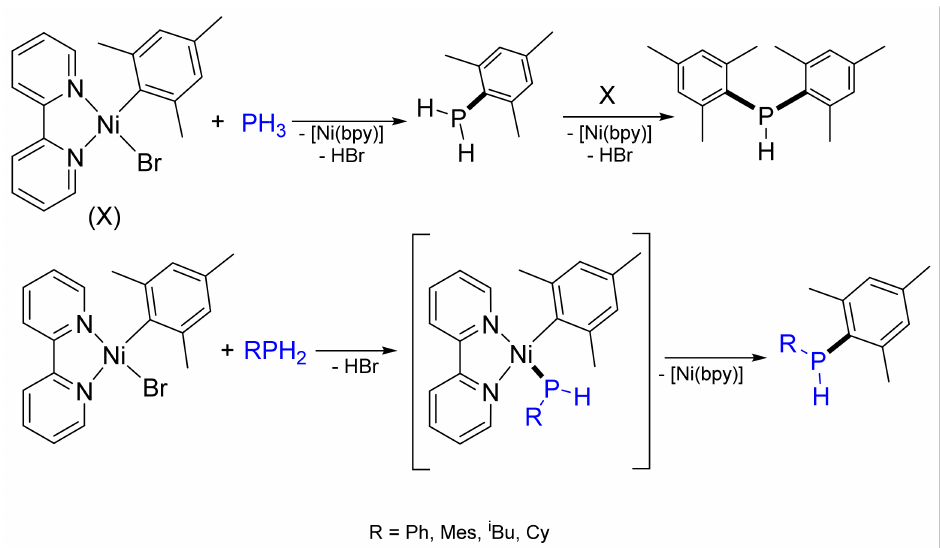
Figure 11. Reactivity of organonickel sigma-complexes with phosphanes.